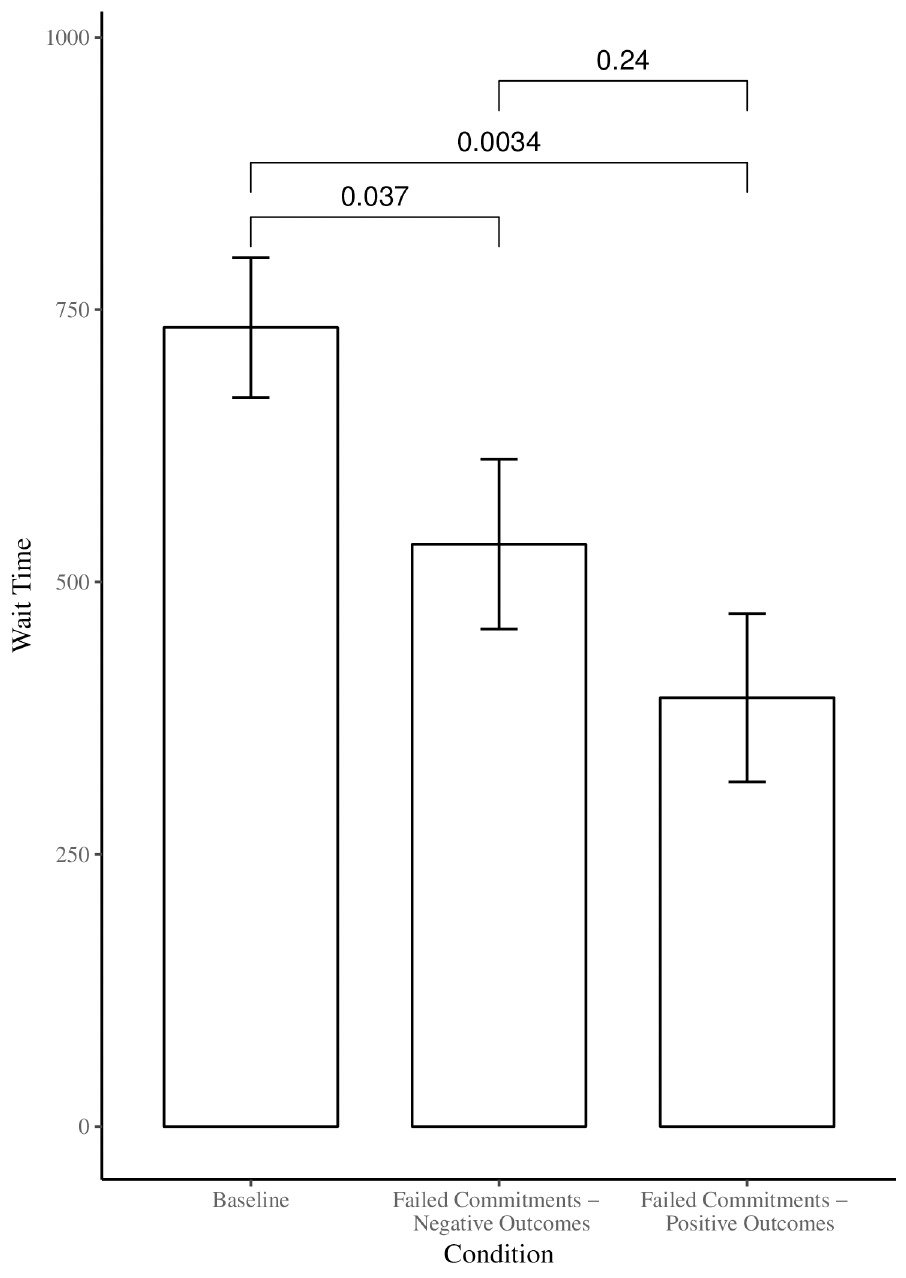
Fig 2. Mean wait time (max wait time = 900s) that participants waited for a second marshmallow as a function of condition. Error bars represent standard errors of the mean. Negative Outcomes and Failed Commitments–Positive Outcomes conditions waited less com- pared to those in the Baseline condition ( p = 0.03 and p = 0.003, respectively). A linear regression analysis was run to test for the effect of age, controlling for condition. Age was significant, (B = 186.94, t = 2.26, p = .02), indicating that 4-year-olds ( M = 643.8s) waited longer than 3-year-olds ( M = 456.8s). In addition, we examined whether differences existed in the proportion of children waiting the entire 15 min without tasting the